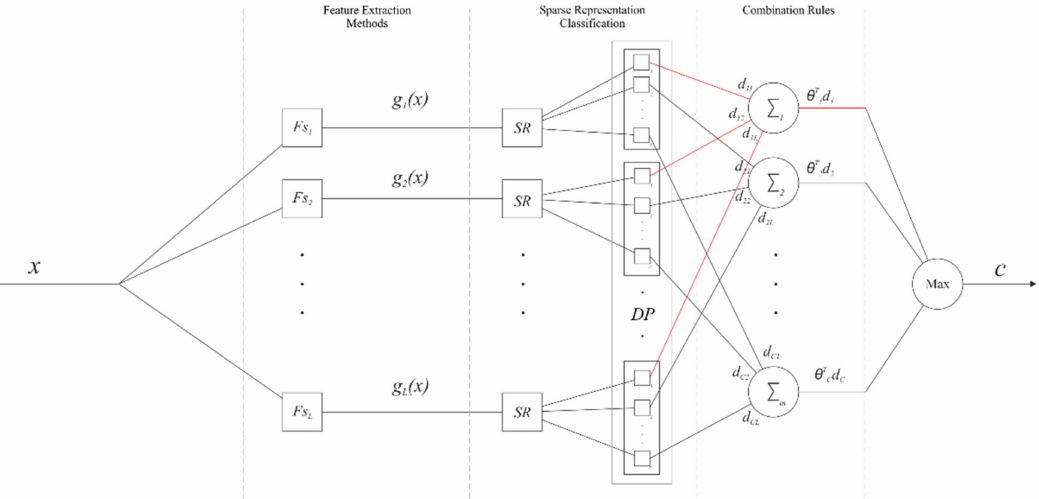
Figure 1. Proposed classifier system, divided into three sections: feature extraction methods, sparse representation classification, and combination